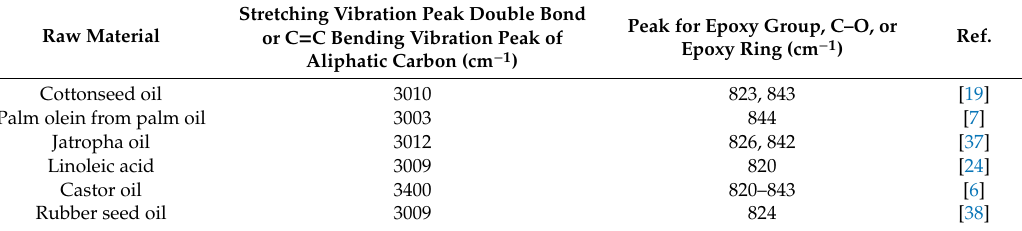
Table 7. FTIR results of the epoxy existence in the